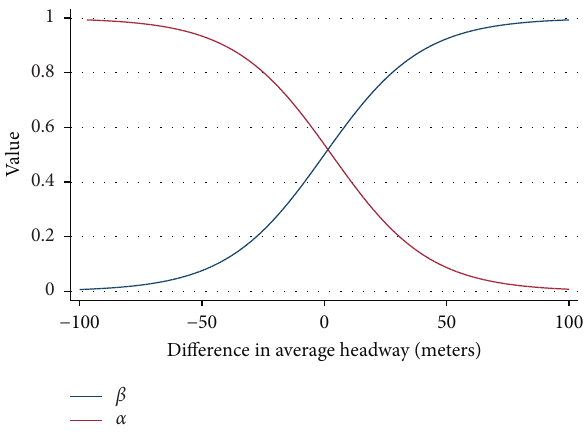
Figure 3: Weight coefficients of safety payoff and space